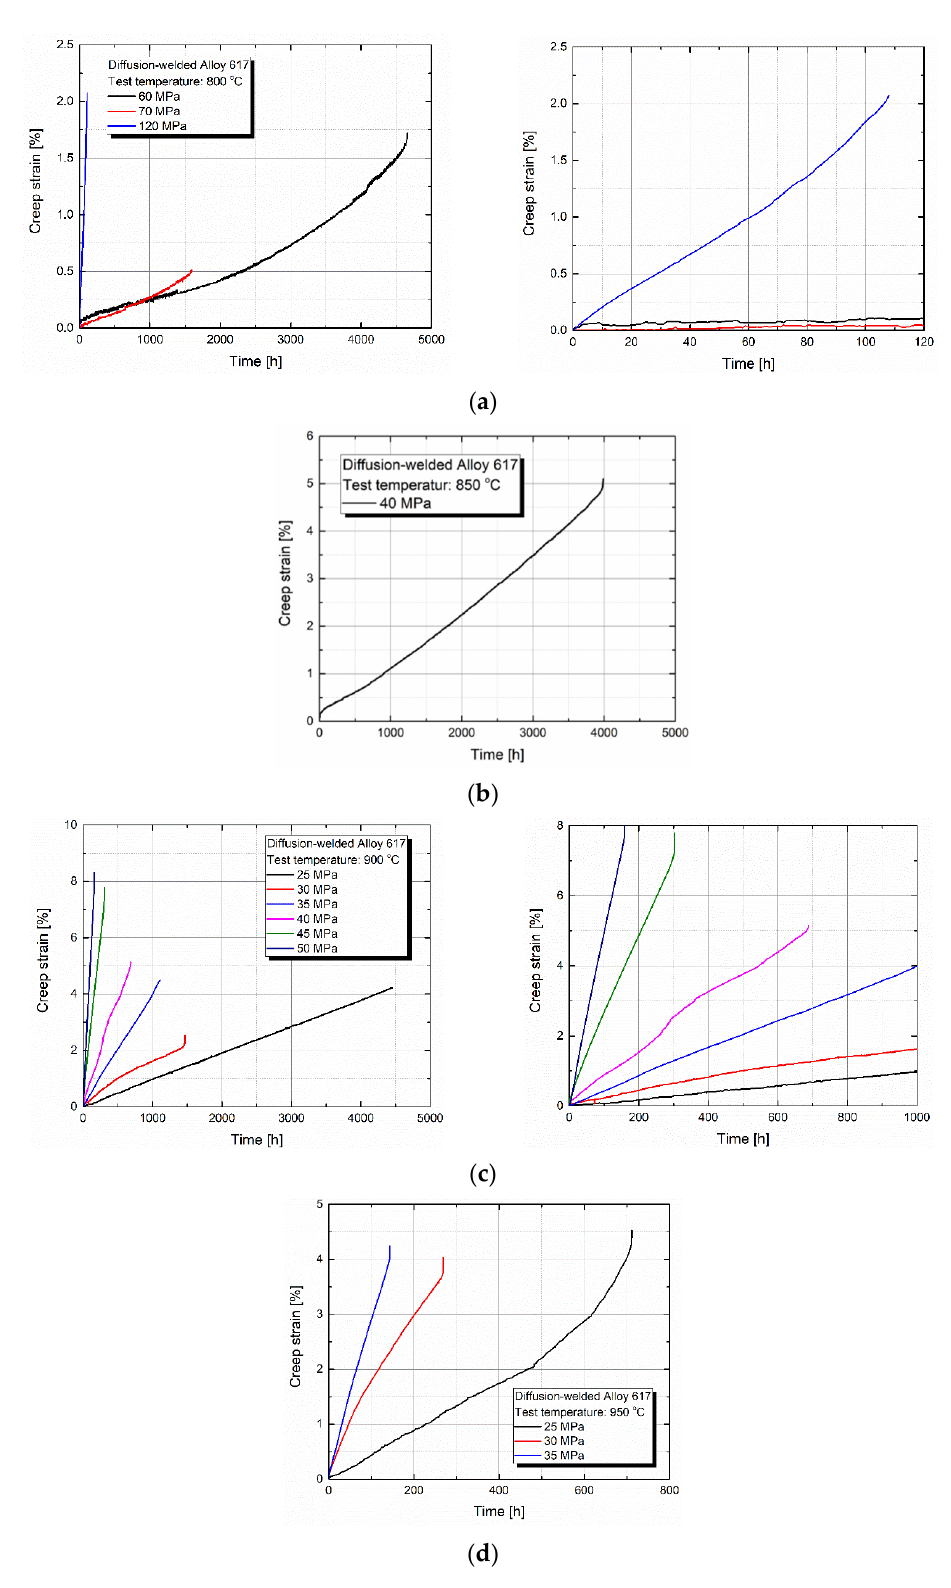
Figure 4. The curves of the creep strain versus time of the diffusion-welded Alloy 617. A stress-rupture test was conducted at: ( a ) 800 °C, ( b ) 850 °C, ( c ) 900 °C, and ( d ) 950 °C. At 800 °C, creep curves were drawn for applied stresses of 60, 70, and 120 MPa (Fig- ure 4a). A test conducted at 100 MPa showed abnormal features in the creep curve, which